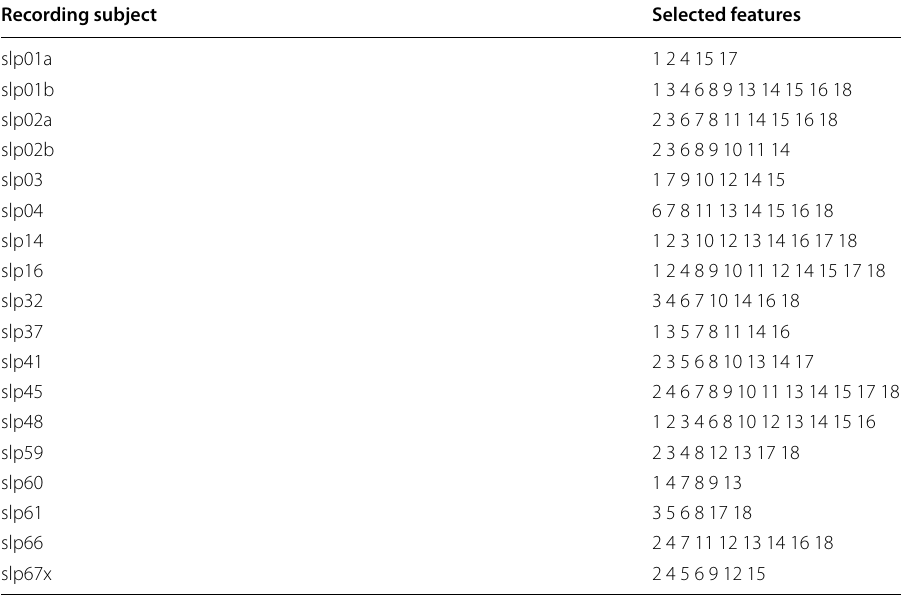
Table 4 The selected features for 6-classes